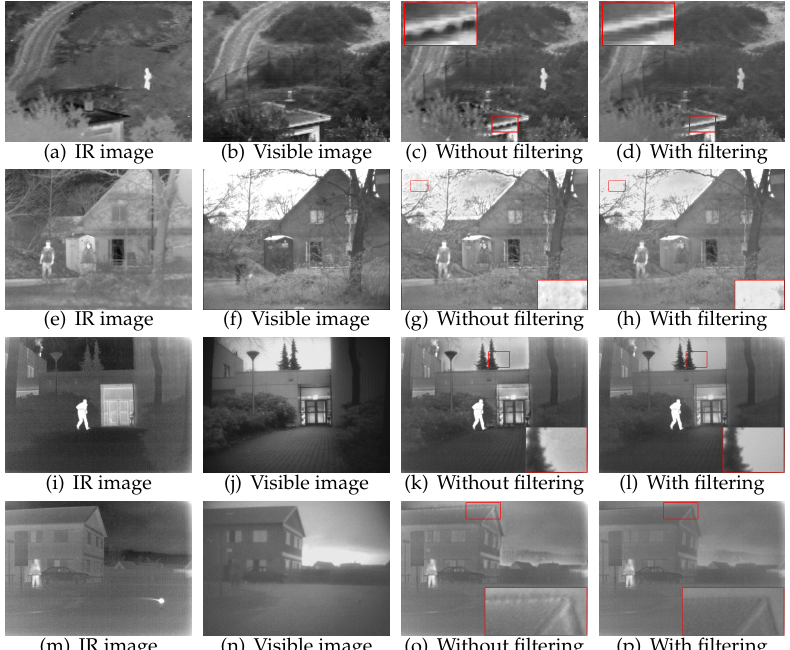
Figure 6. The ablation study of the guided filter. The first column has IR images, the second column has visible images, the third column has images produced without guided filtering, and the fourth column has images produced with guided